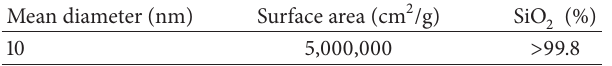
Table 3: Properties of nanosilica.